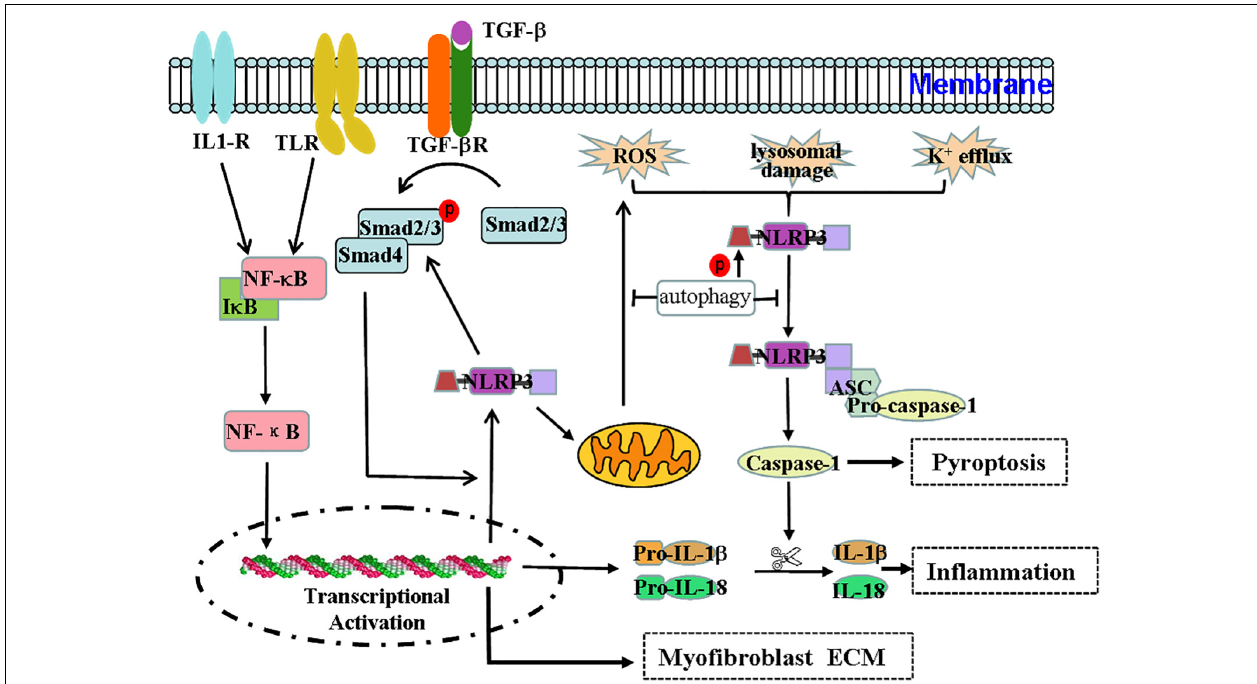
FIGURE 1 | Effect and regulation of the NLRP3 inflammasome during renal fibrosis. The NLRP3 inflammasome not only mediates the inflammatory response but is also associated with pyroptosis, mitochondrial regulation, and myofibroblast differentiation during renal fibrosis. Regulation of the NLRP3 inflammasome during renal fibrosis is mediated by the following pathways. (1) Microbial molecules or endogenous risk factors up-regulate the expression of NLRP3, pro-IL-1 β , and pro-IL-18 through the NF- κ B signaling pathway to induce events such as K + efflux, the generation of ROS or lysosomal damage, and others. (2) This triggers the oligomerization and activation of NLRP3 and the recruitment of the adapter protein ASC and pro-caspase-1. Pro-caspase1 undergoes autoproteolytic cleavage into bioactive caspase-1, which in turn acts on pro-IL-1 β and pro-IL-18 to produce IL-1 β and IL-18 to mediate inflammation and pyroptosis. (3) TGF- β signaling participates in the transdifferentiation of myofibroblasts and the production of ECM. (4) The TGF- β /Smad pathway can stimulate the expression of NLRP3, which is also involved in TGF- β -mediated Smad2/3 phosphorylation. Thus, the interaction between the NF- κ B/NLRP3/caspase-1/IL-1 β /IL-18 axis and the TGF- β /Smad signaling pathway may form a pathogenic cycle that leads to the development of renal fibrosis. (5) Additionally, NLRP3 may damage mitochondrial morphology and induce mitochondrial ROS production, ultimately promoting NLRP3 inflammasome activation. (6) Autophagy can negatively regulate the NLRP3 inflammasome by decreasing the levels of ASC and the phosphorylation of the NLRP3 protein and by purging mitochondrial